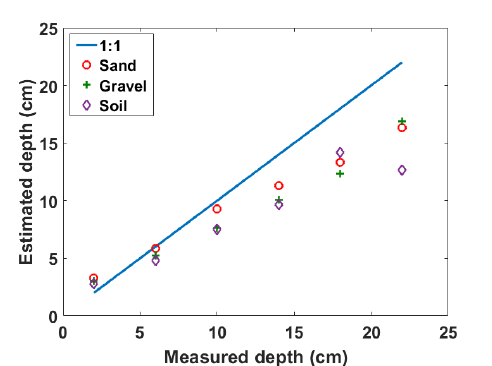
Figure 8. Estimated depths of the buried Cs-137 source for the three